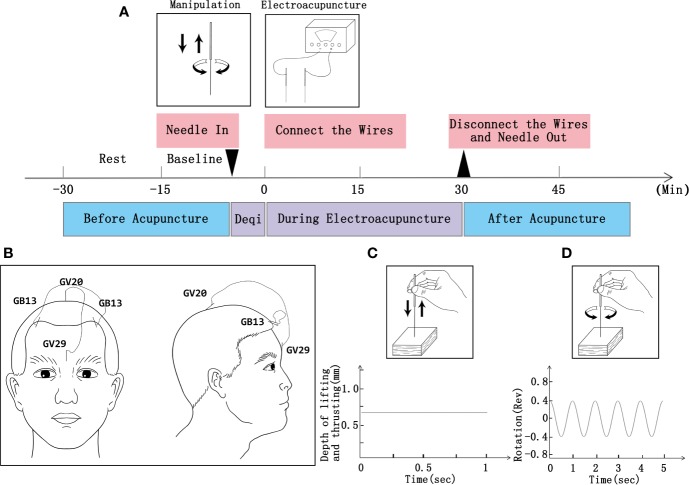
Procedure of EA and operation parameters. (A) Schematic protocol of EA manipulation (3 times a week for 6 weeks; 30 min a session). (B) Locations of acupoints. (C) Operation parameters for lifting and thrusting. (D) Operation frequency of twirling and rotation.